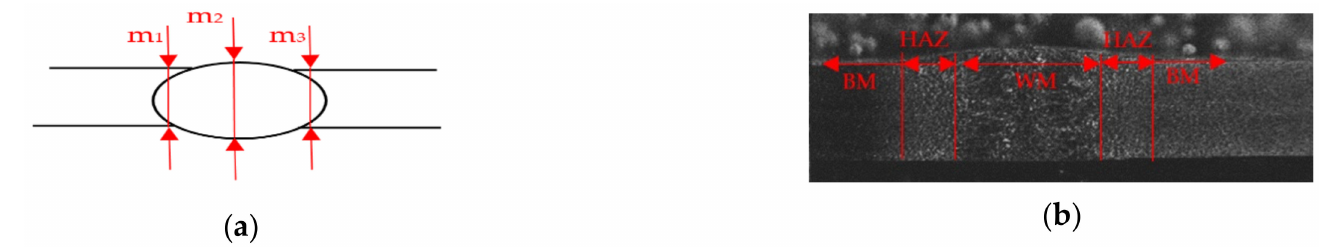
Figure 10. Measurement of dimensions on samples—( a ) measuring points, ( b ) sample